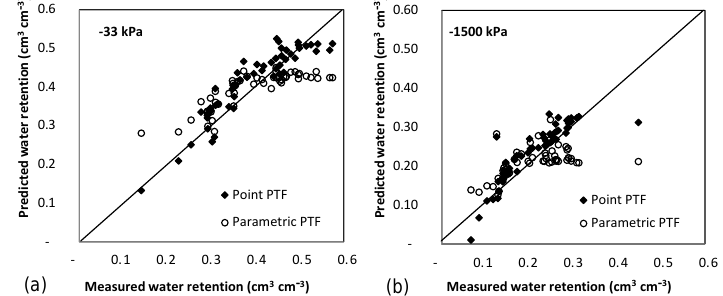
Figure 3. Scatter plots of measured soil water retention versus predicted soil water retention.